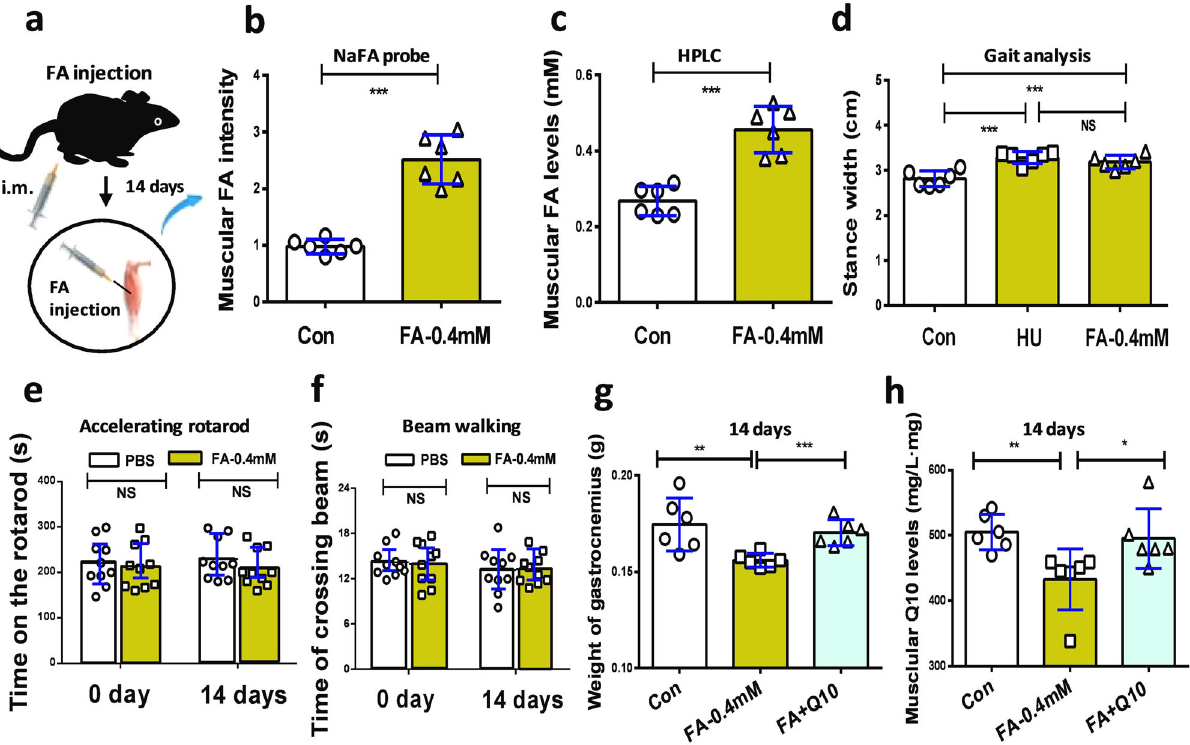
Fig. 5 Injection of formaldehyde into the gastrocnemius muscle led to gait instability in healthy wild-type mice. a Formaldehyde at 0.4 mM was injected into the muscle of hindlimb for 14 consecutive days. i.m. intramuscular injection. b Muscular formaldehyde levels quanti fi ed by NaFA probe ( n = 6). c Formaldehyde levels in the gastrocnemius detected by HPLC ( n = 6). HPLC high-performance liquid chromatography. d Gait analysis of the stance width in Con, HU model, and FA-injected mice. Con: the wild-type mice; HU: hindlimb unloading; FA: formaldehyde ( n = 6). e Motor behaviors assessed by the accelerating rotarod test ( n = 6). f Motor functions evaluated by the beam walking test ( n = 10). g Weights of gastrocnemius ( n = 6). h Muscular Q10 levels detected by Q10 kits ( n = 6). Error bars show the mean ± S.E.M; NS no statistical signi fi cance; * p < 0.05; ** p < 0.01; *** p <